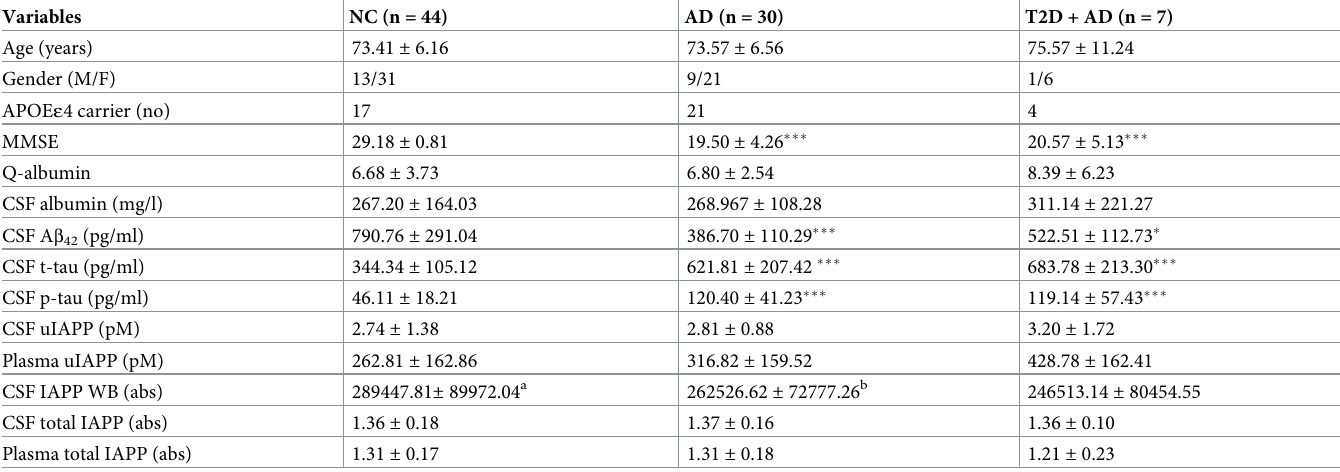
Table 1. Data on individuals included in the